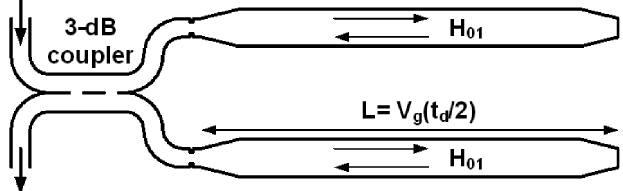
compressor.*Corresponding author.